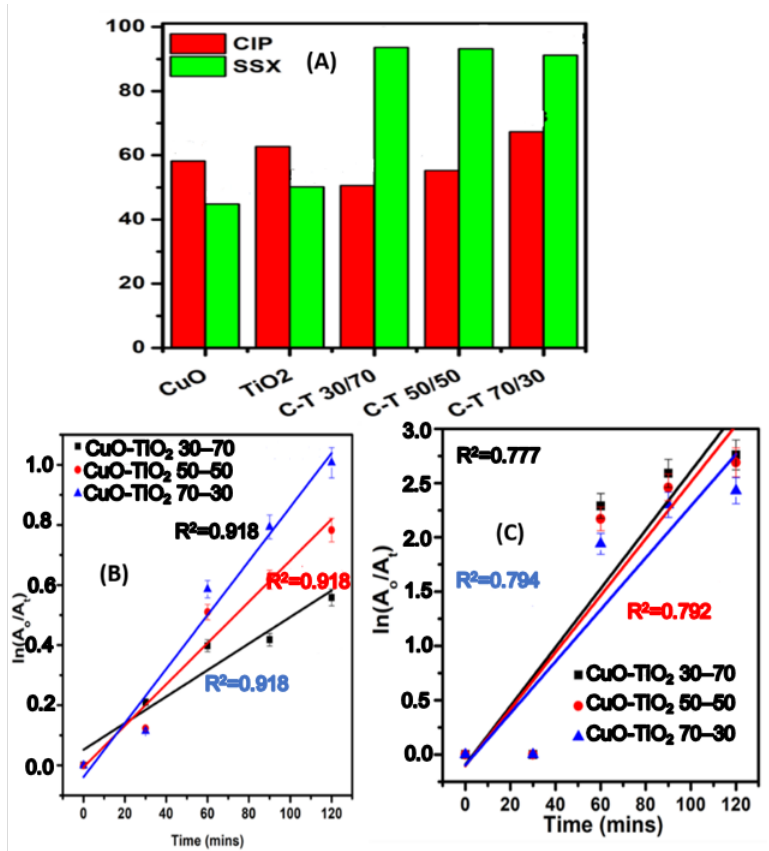
Figure 11. ( A ) Photocatalytic degradation of various materials against SSX and CIP, ( B ) kinetics of CIP, and ( C ) kinetics of SSX.